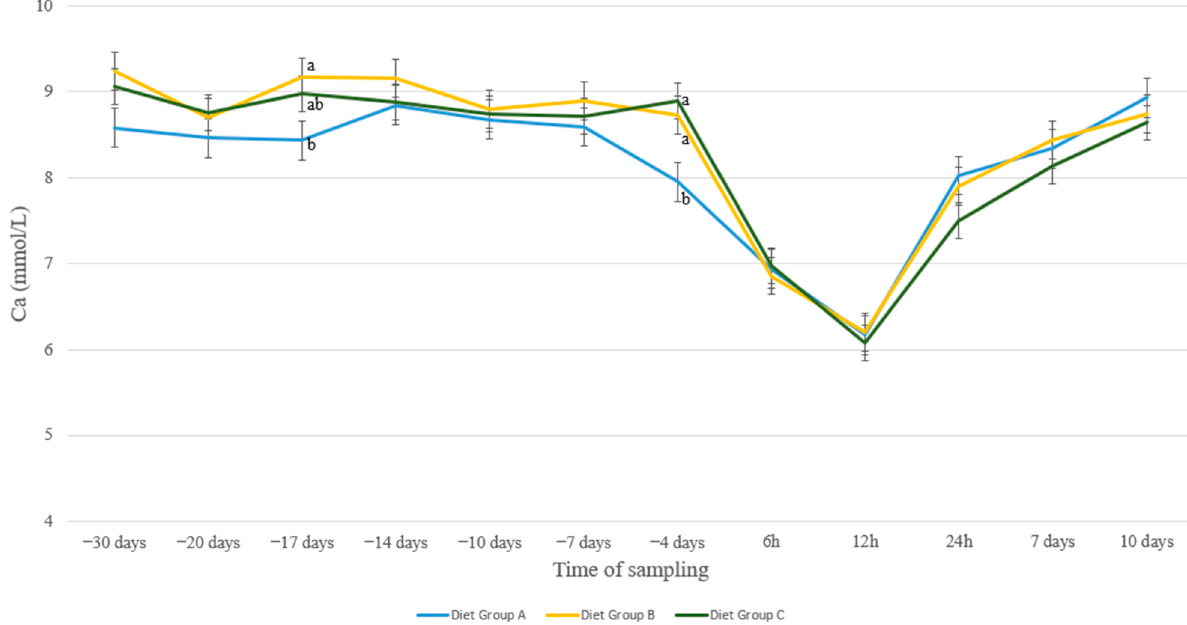
Figure 1. Ca levels (mmol/L) in blood serum of sheep in group A (control group, n = 27), group B (supplemented diet with beet pulp, n = 31), and group C (supplemented diet with beet pulp and ammonium chloride, n = 29) during the peri-parturient period. a,b Different letters denote significant differences between groups within evaluation time ( p < 0.05).